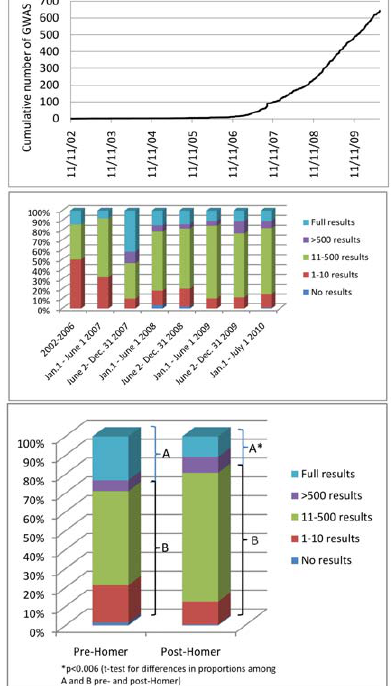
Figure 1. Temporal trends in GWAS publications and results availability. Top panel: Cumulative chronological release of 643 GWAS papers at their earliest release dates. Middle panel: Distribution of GWAS papers among five categories of reported maximum results availability from 2002 to 2006, and in 6-month intervals from January 1, 2007 to July 1, 2010. Bottom panel: Distribu- tion of 643 GWAS papers among five catego- ries of reported maximum results availability by open access or controlled access applica- tion in the period before October 1, 2008 (left) and from October 1, 2008 to July 1, 2010 (right).